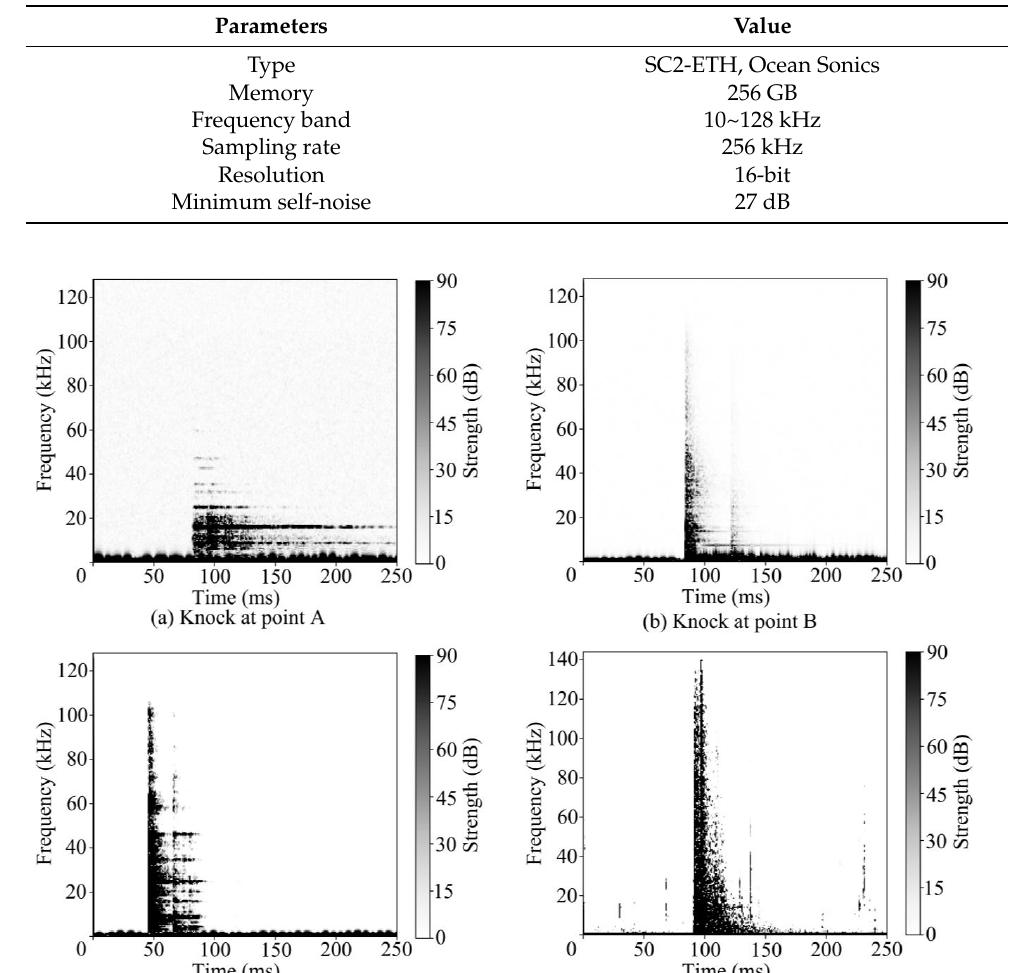
Figure 5. Sketch map of the knocking test. Table 6. Parameters of the hydrophone for data collection.